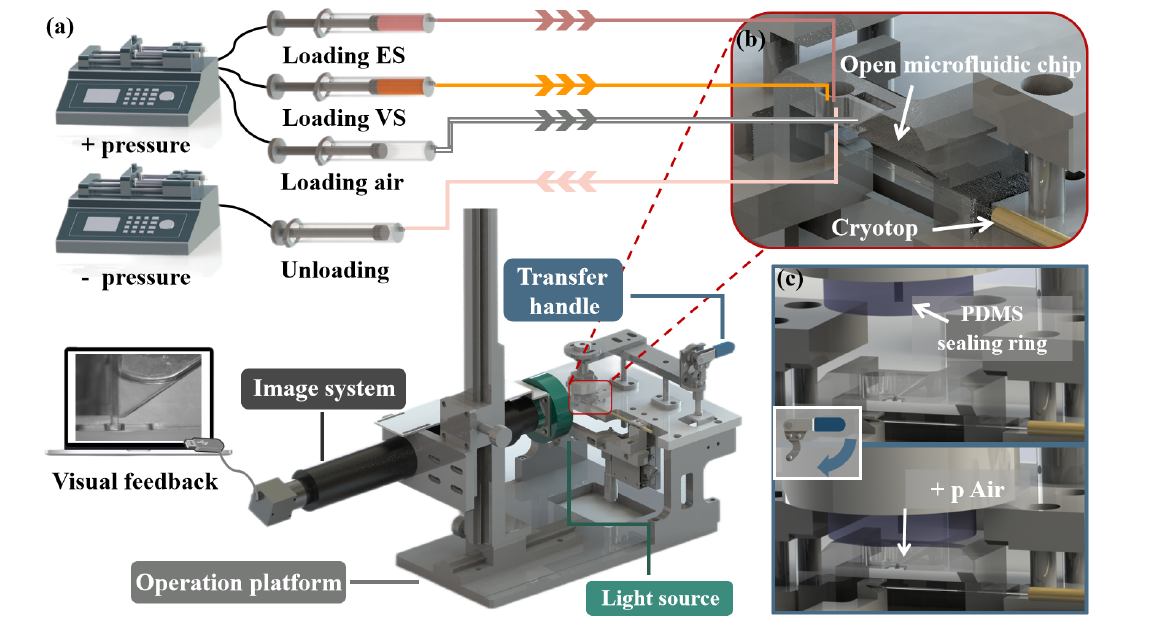
Figure 2. The structure diagram of the vitrification system and working principle of system. ( a ) The vitrification system composed of the open microfluidic chip and the companion system (syringe pumps, operation platform, transfer system and the imaging system). The operator manual placed the oocyte into the chip, completed the vitrification pretreatment and transferred with the assistance of the companion system. The real-time internal conditions of the chip on the whole operation process were presented to the operator by visual feedback. ( b ) Above all, Cryotop and the open microfluidic chip containing the oocyte were fixed on the operation platform. The syringes used for loading (ES, VS and air) and unloading were, respectively, connected to the chambers on both sides of the chip and PDMS sealing ring with soft silicone tubes. ( c ) Schematic diagram of the transfer process. After vitrification pretreatment, the operator pressed the transfer handle, and the PDMS sealing ring was pressed on the upper surface of the open microfluidic chip to form a hermetic space. The oocyte was transferred to Cryotop by external